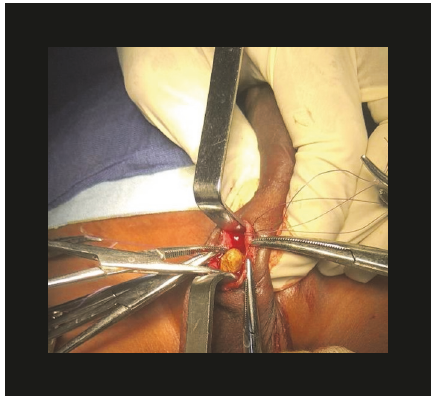
Figure 13: Urethral stone extraction (case 3).